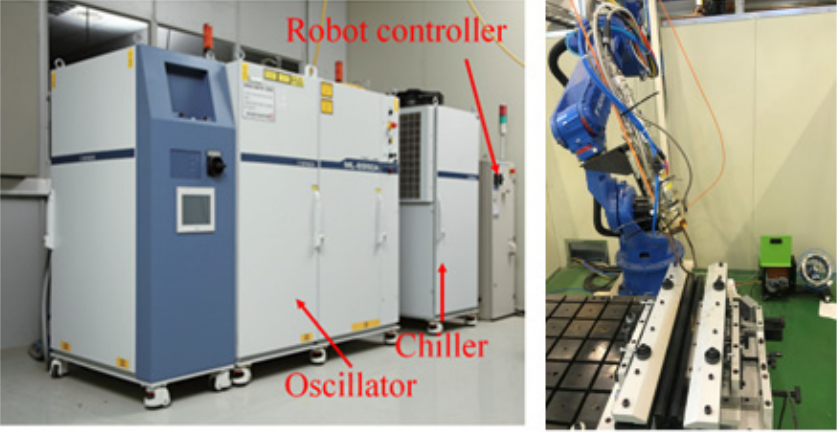
Figure 3. Fiber laser equipment.